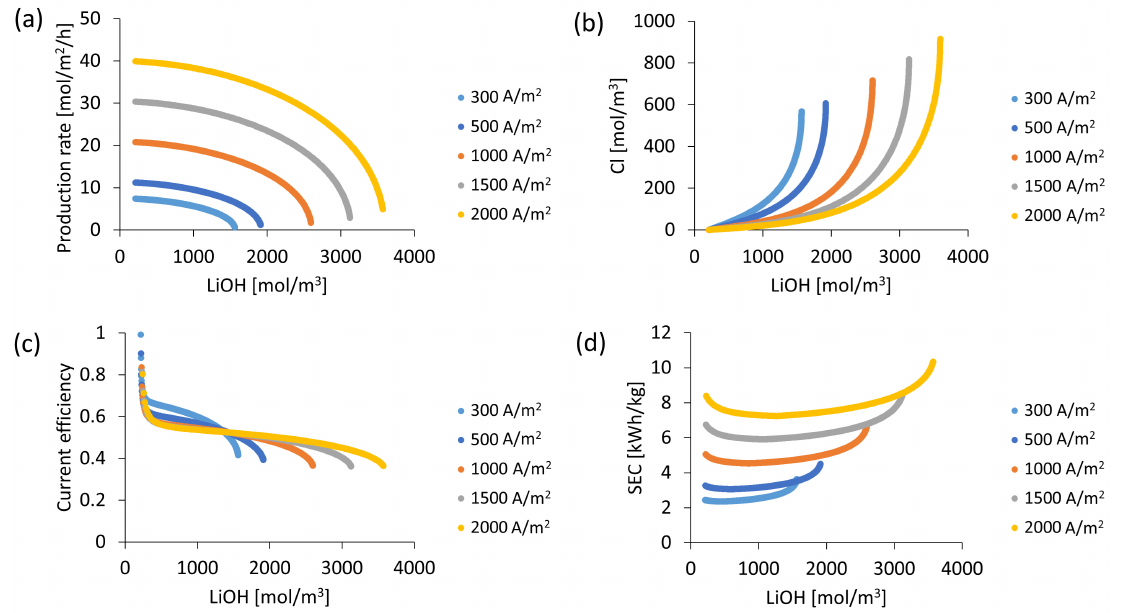
Figure 7. Process performance according to electric current density applied at an initial concentra- tion of LiCl 6800 mol/m 3 : ( a ) LiOH production rate; ( b ) Cl − concentration; ( c ) Current efficiency; ( d ) Specific electricity consumption (SEC).